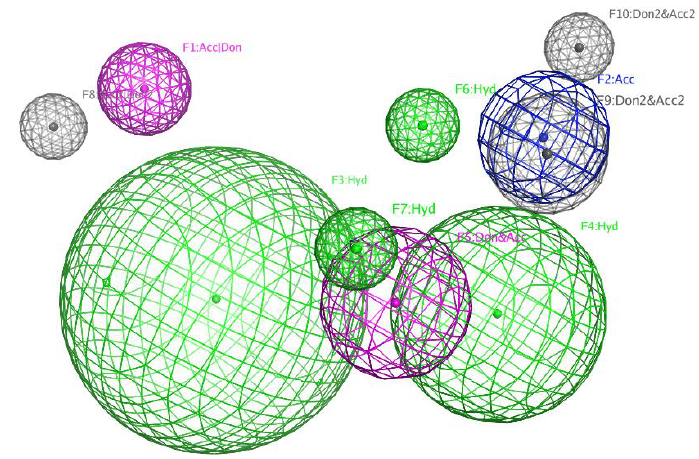
Figure 7. Pharmacophore model of 36-membered guanidine-containing polyhydroxyl macrolides obtained by Discovery Studio 3.5. Ten pharmacophore features were